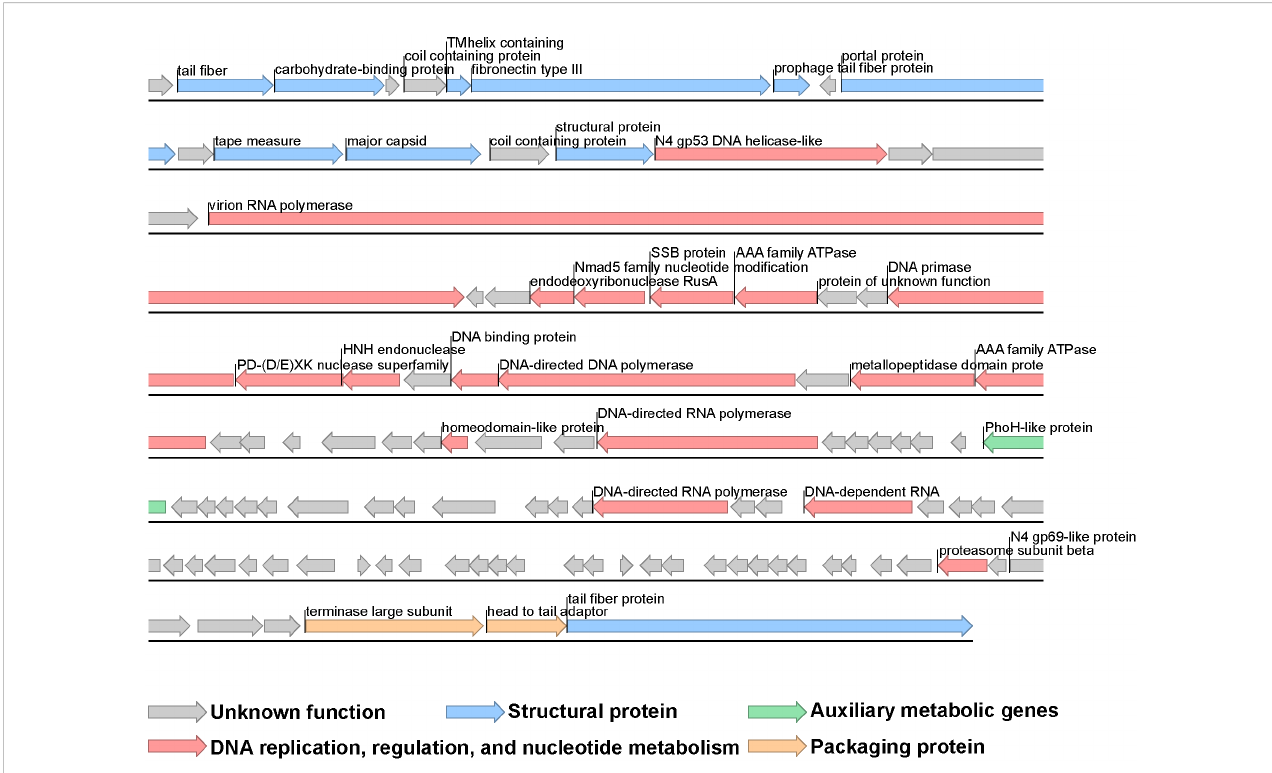
FIGURE 3 Genome map of Vibrio phage vB_VhaP_PG11. Putative functional categories are de fi ned according to annotation and are represented by different colors. The length of each arrow represents the length of each